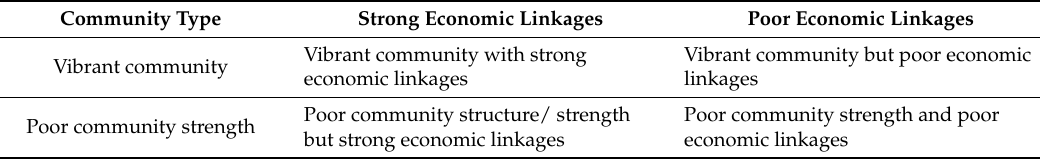
Table 6. Possible local context conditions for intervention design. Source: Based on